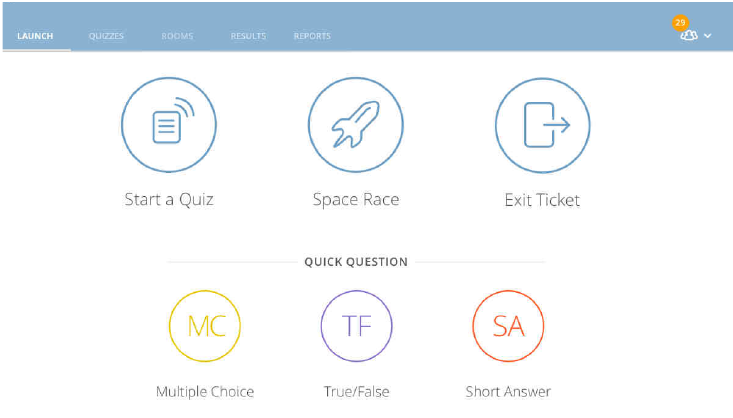
Fig. 5. Socrative